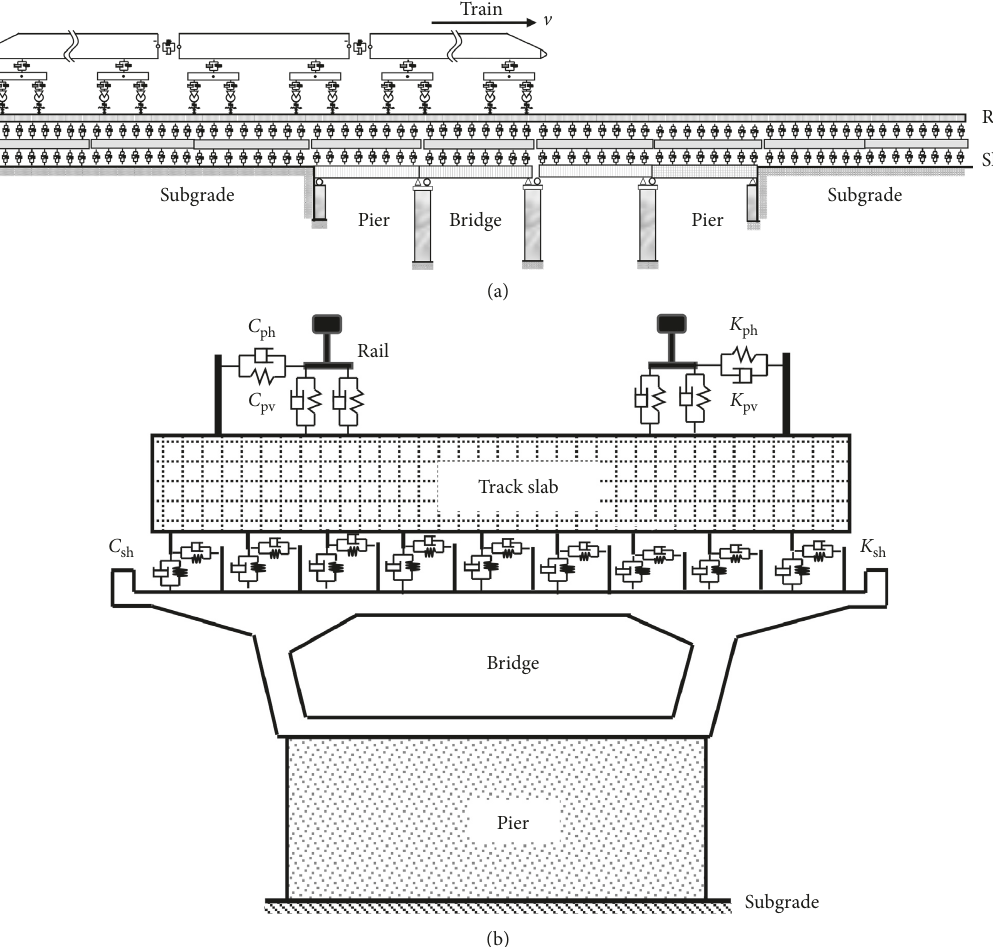
Figure 1: High-speed train-track-bridge coupled dynamic model: (a) side view and (b) end